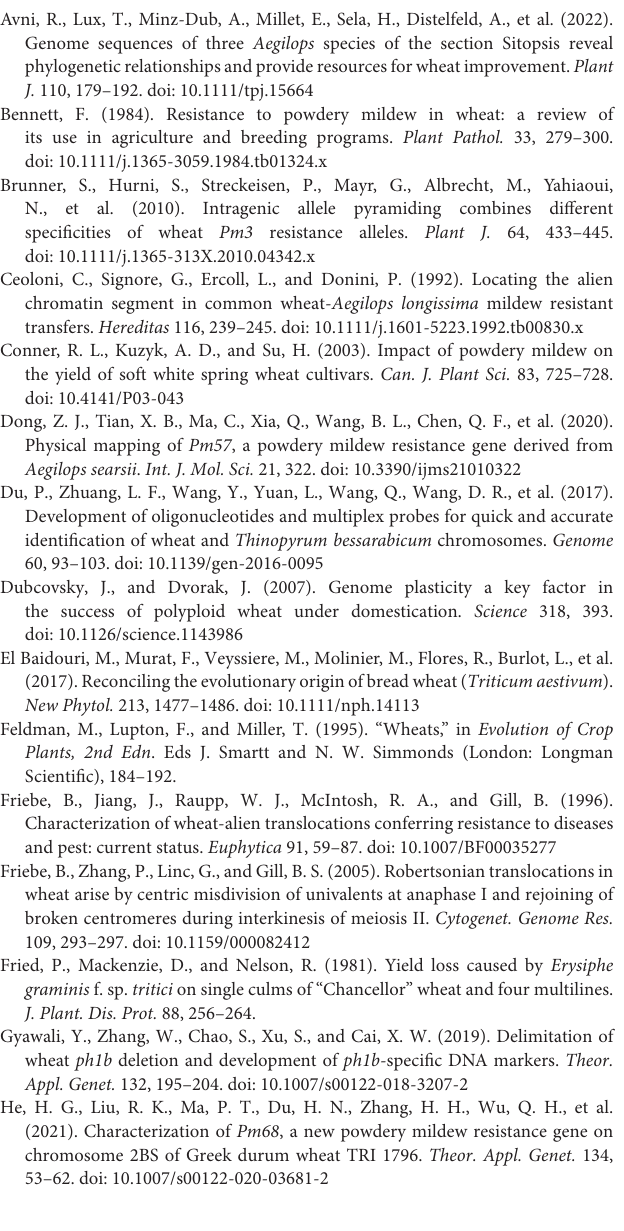
Supplementary Figure S1 | Characterization of 6S l #3 recombinants by wheat SSR markers and 6S l #3-specific markers. Wheat 6A chromatins were represented by red column, 6B by purple and 6S l #3 by green. Wheat 6A and 6B SSR markers